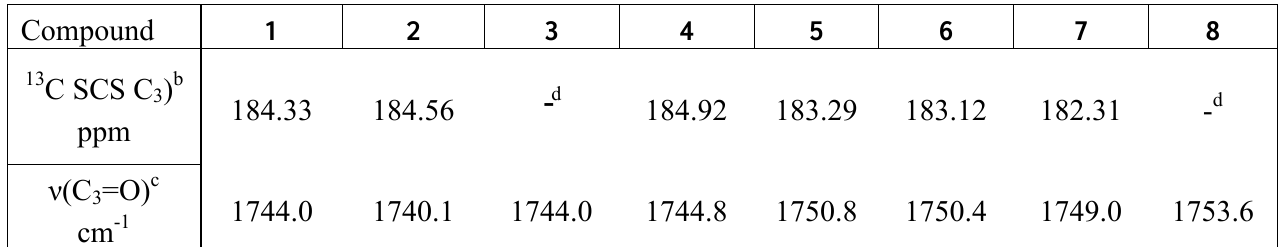
Table 1. Selected IR and 13 C NMR spectral data a for 5-substituted indole-2,3-diones (1-8)